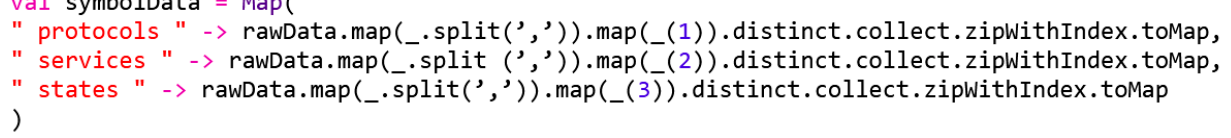
Figure 7. Transformation of categorical characteristics into three indexed map instances.